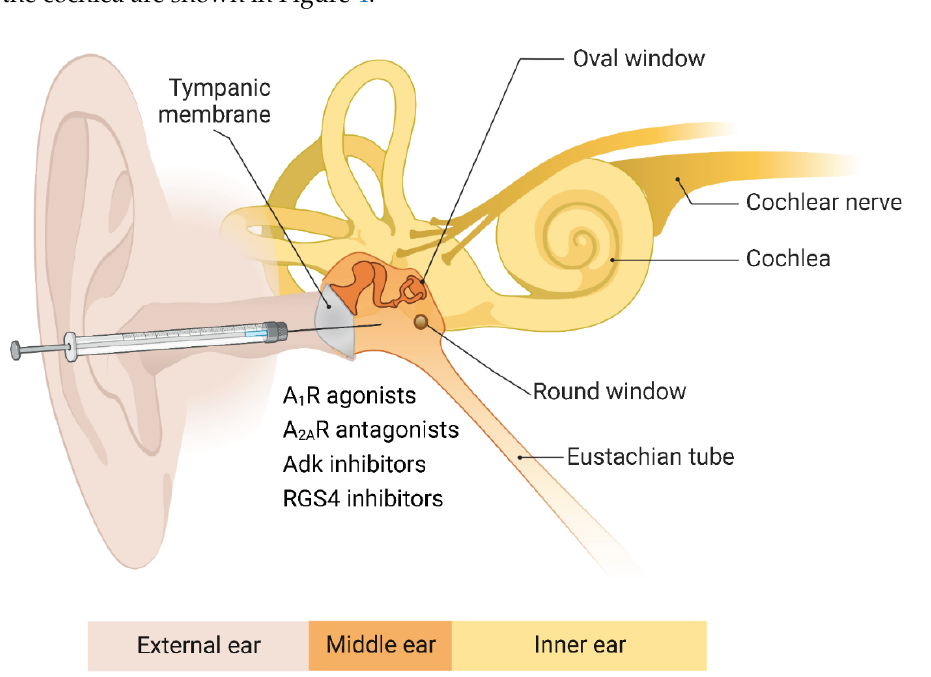
Figure 4. Cochlear protection by adenosine receptors. The preclinical studies established four distinct strategies targeting adenosine receptors to rescue the cochlea from injury and prevent sensorineural hearing loss. These pharmacological interventions include the administration of A 1 re- ceptor agonists, A 2A receptor antagonists, adenosine kinase (Adk) inhibitors and RGS4 (Regulator of G protein signalling 4) inhibitors. The most common route for drug delivery to the inner ear is the intratympanic injection onto the round window membrane of the cochlea, which precludes off-target effects associated with systemic administration. Created with